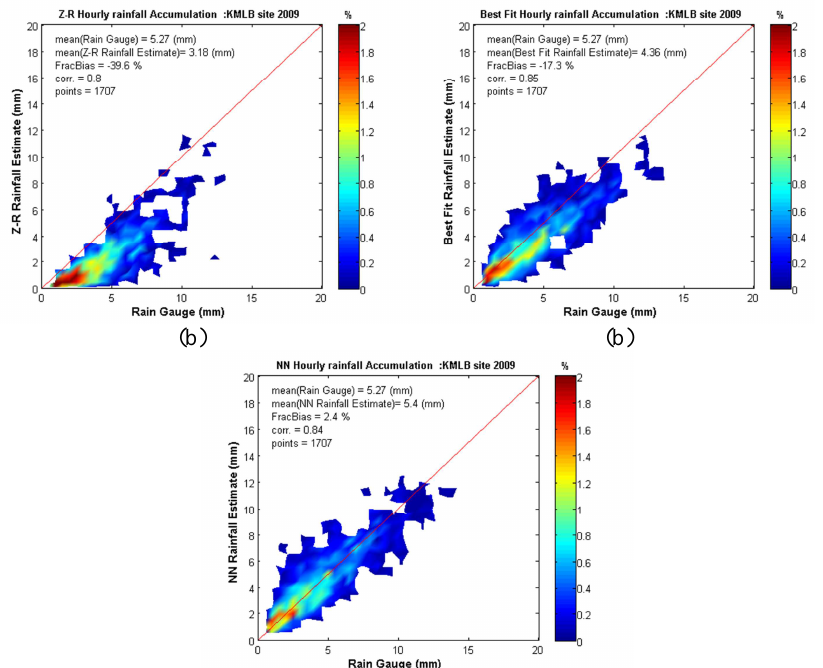
Fig. 9. Actual rain gauge vs. (a) Z – R estimate (b) best-fit estimate and (c) NN estimate. Data from year 2009 over KMLB. (Hourly rainfall